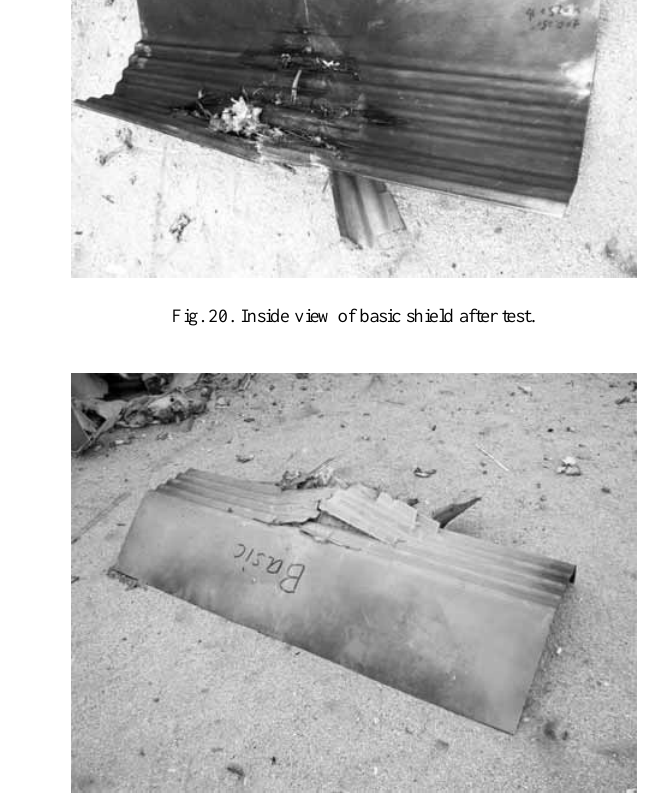
Fig. 21. Outside view of basic shield after